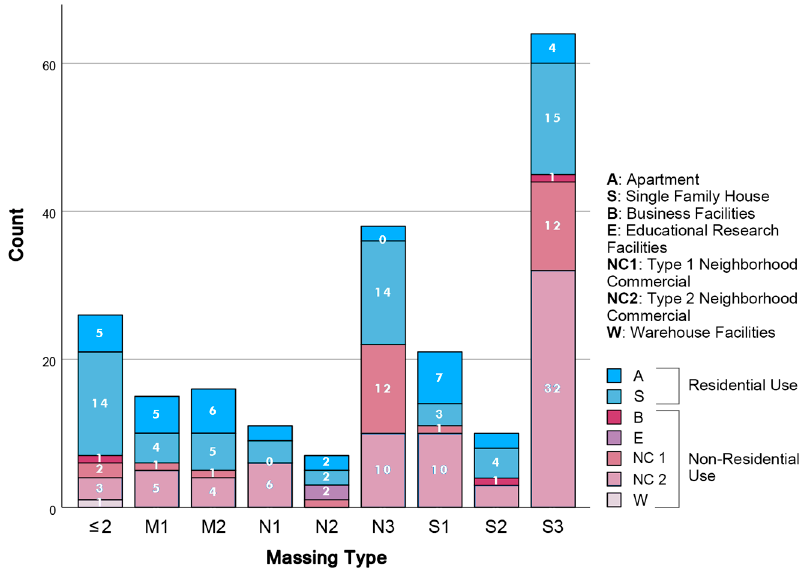
Figure 16. Number of properties per primary program.